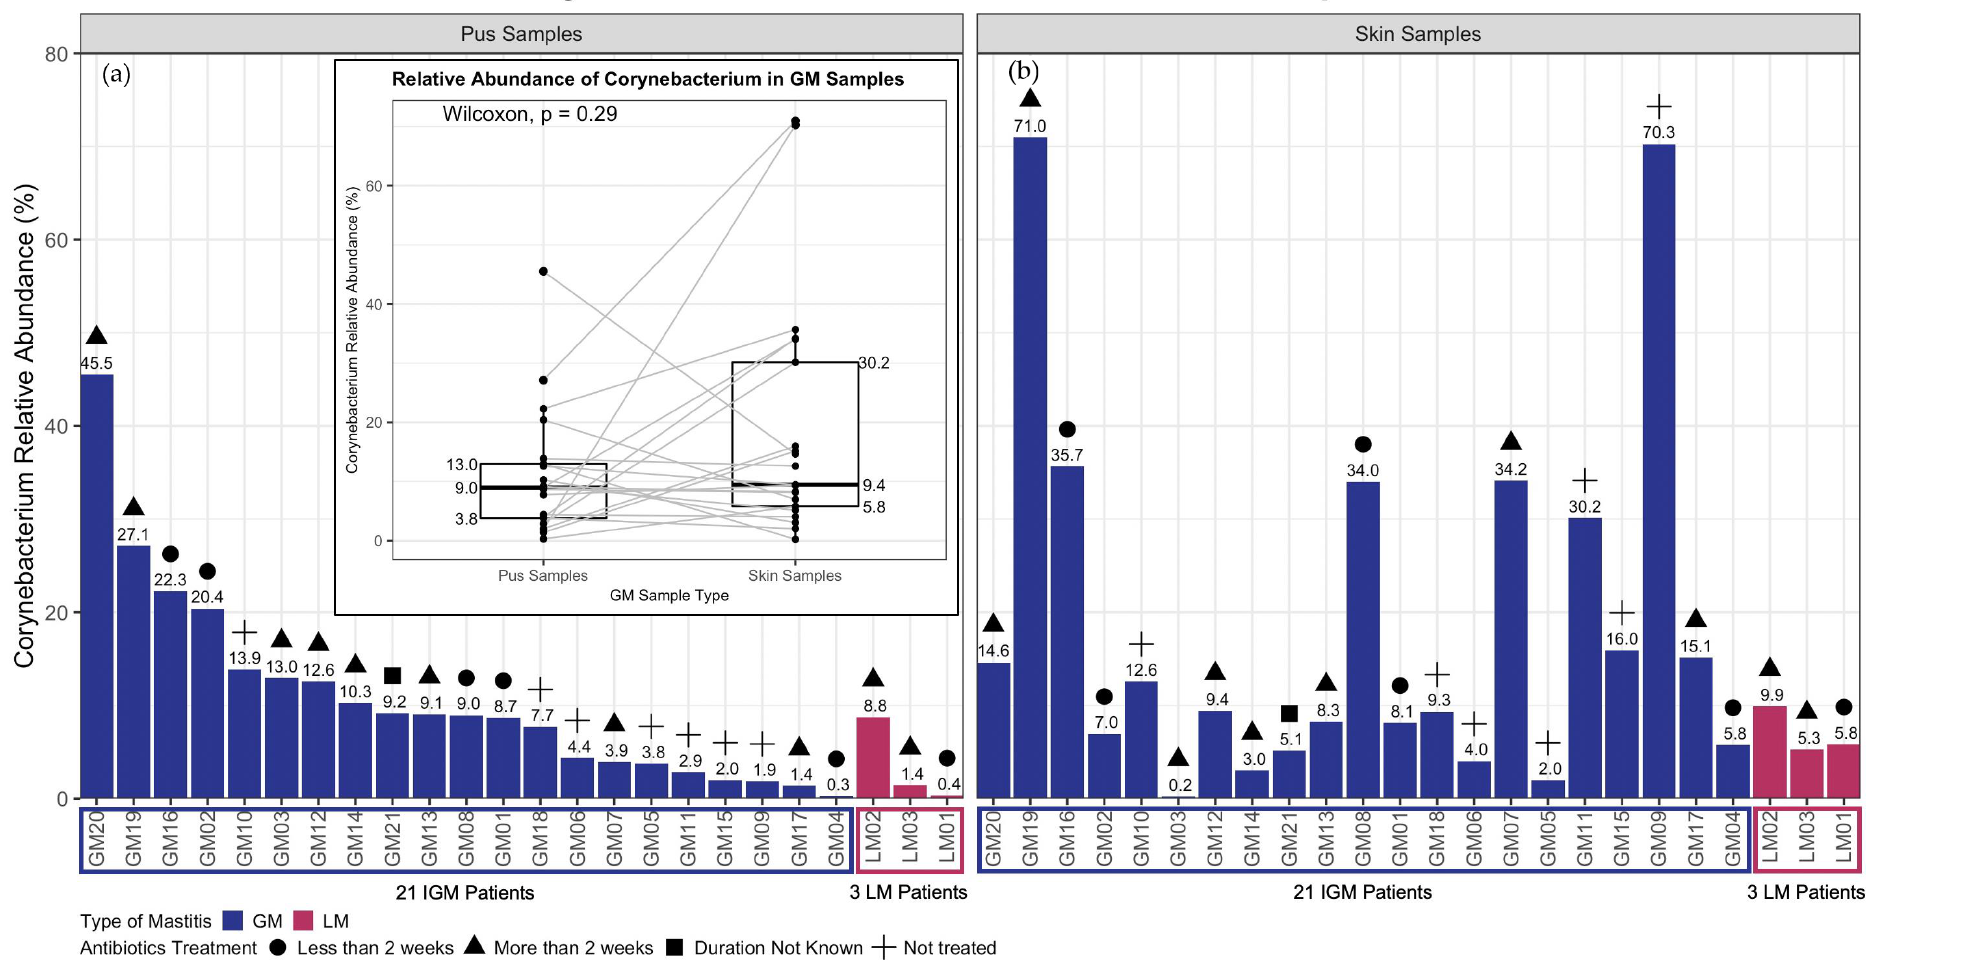
Figure 3. Relative abundance of Corynebacterium genus in breast ( a ) pus and ( b ) skin samples from patients with idiopathic granulomatous mastitis (IGM) and control patients with lactating mastitis (LM). The left-end bars in both panels represent the 21 patients with IGM, and the right-end bars in both panels represent